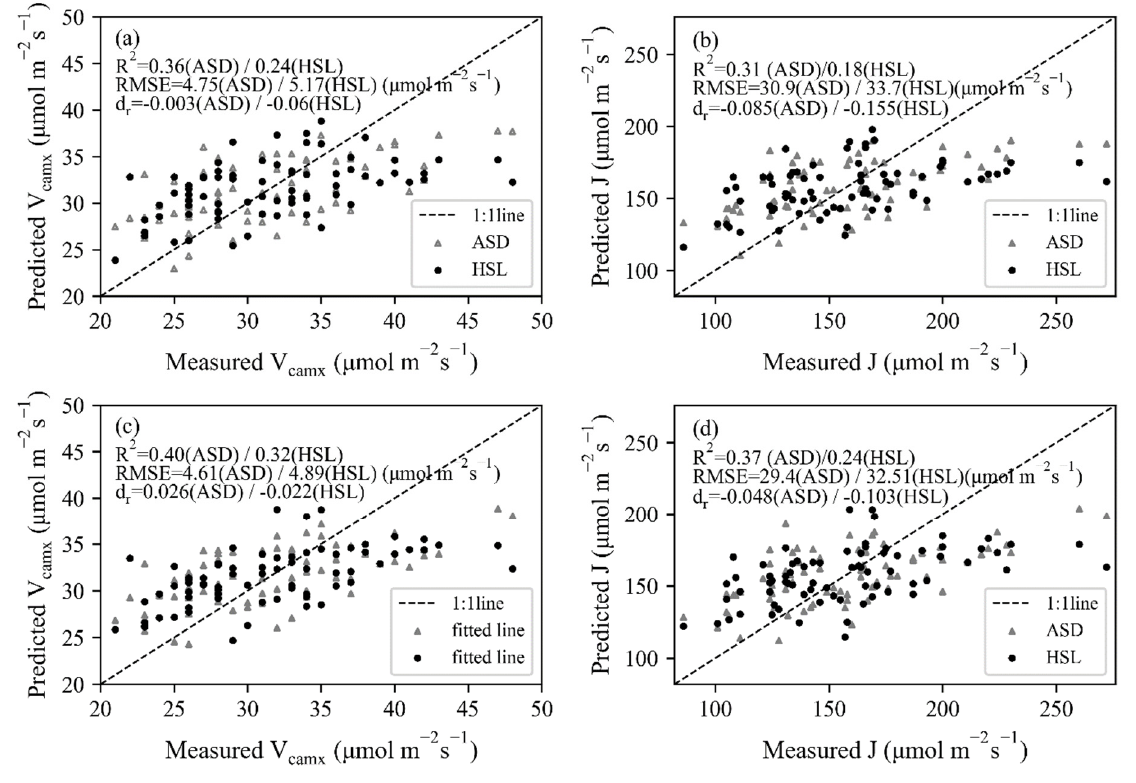
Figure 8. The relationships between measured and estimated V cmax and J using ( a , b ) chlorophyll-based method and ( c , d ) N-based method for HSL and ASD data.